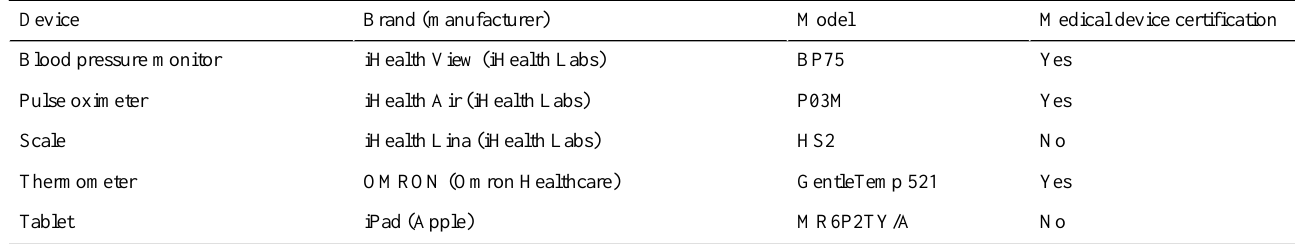
Table 1. Contents of the remote telemonitoring